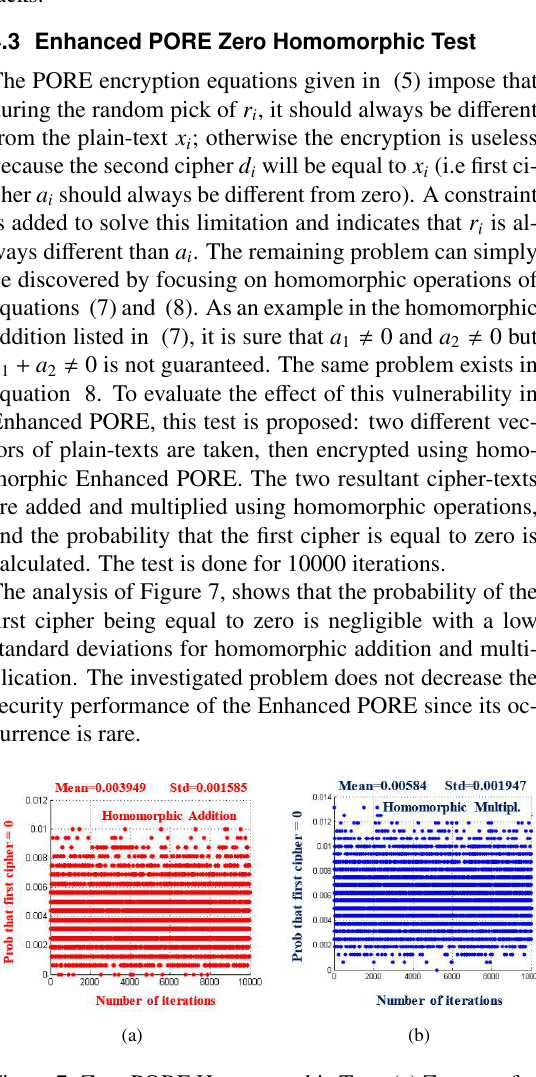
Figure 7: Zero PORE Homomorphic Test: (a) Zero test for addition (b) Zero test for